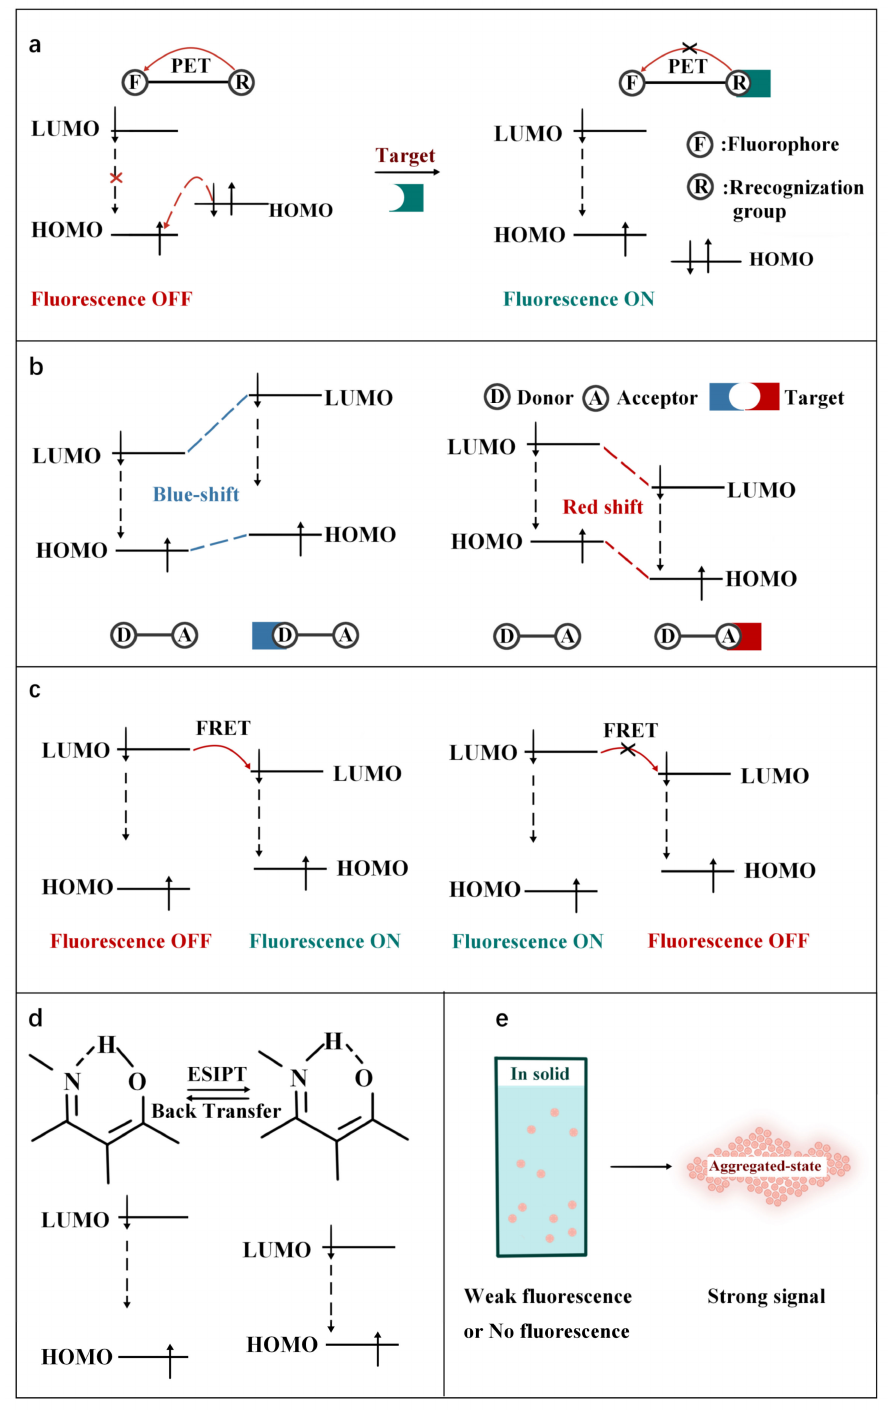
Figure 2. Schematic illustration of the principles of ( a ) PET, ( b ) ICT, ( c ) FRET, ( d ) ESIPT and ( e )